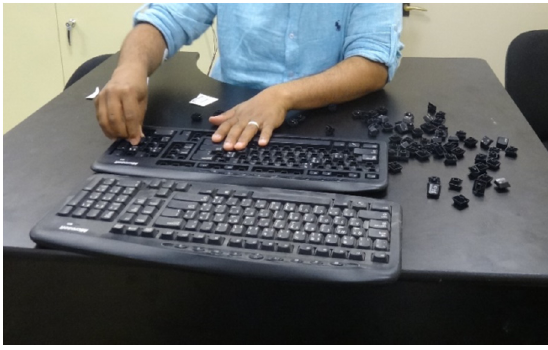
Figure 2. Assembling task.